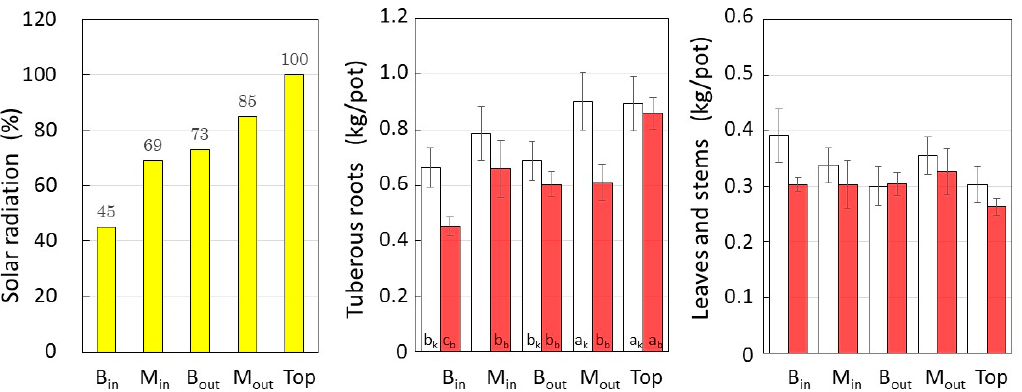
Figure 2. The amount of solar radiation in each layer, and the fresh weight of tuberous roots, leaves, and stems per pot harvested in each layer. Symbols: □ ; Suikenkintoki , ■ ; Beniharuka . Data are means and error bars represent standard error of the mean. Different letters indicate statistically significant differences between cultivation layers ( p < 0.05).